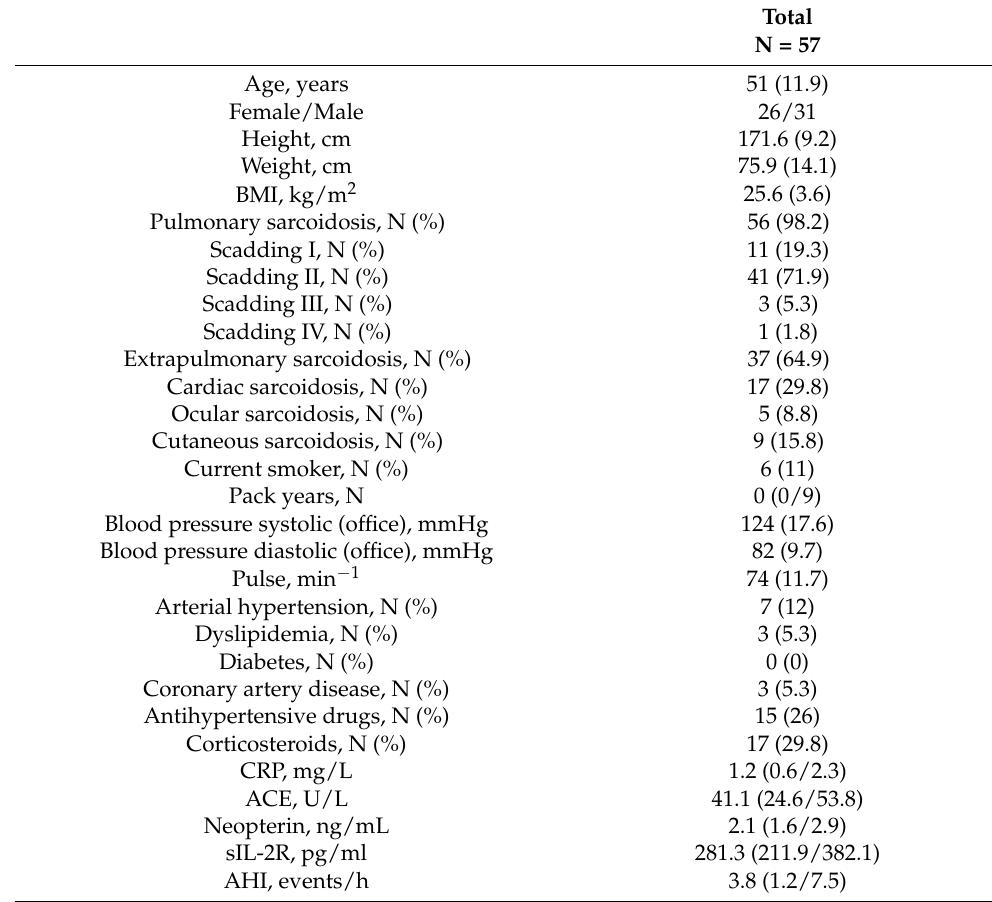
Table 1. Baseline